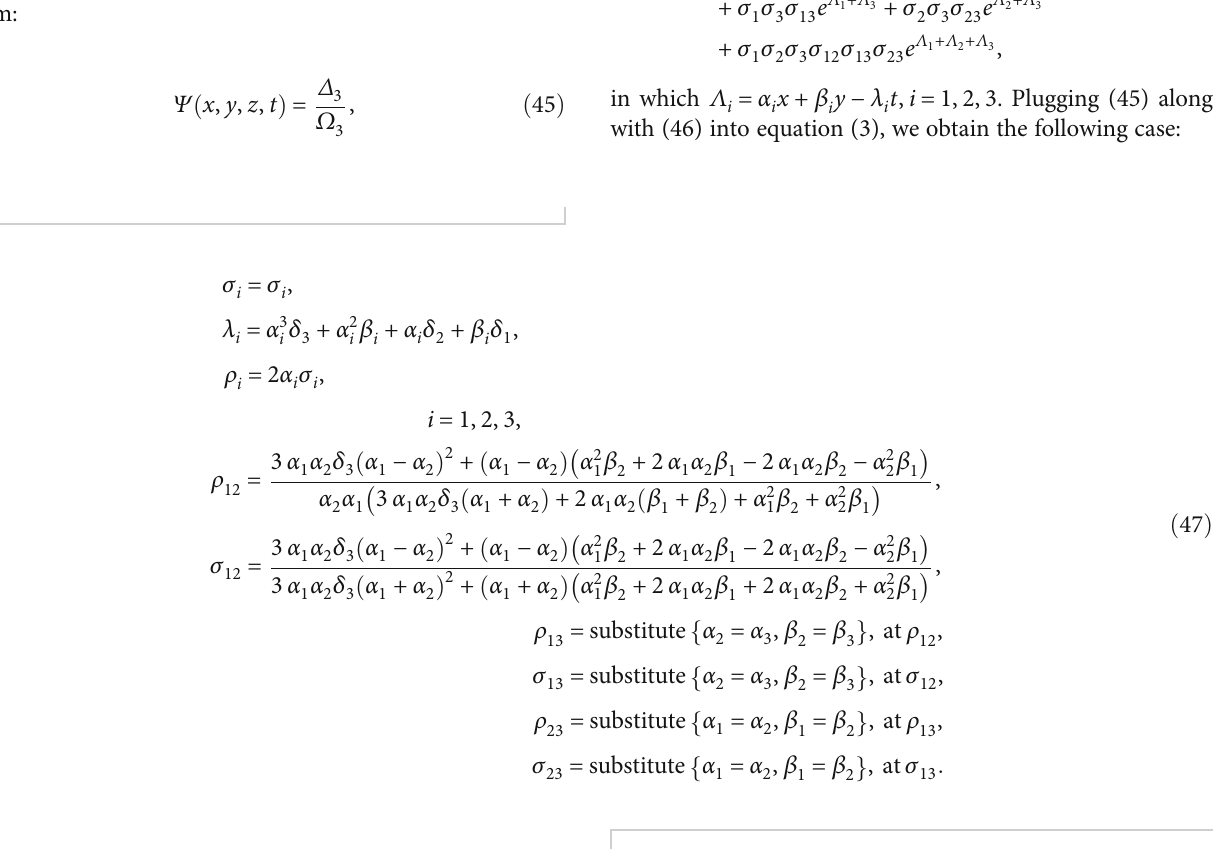
= 1 : 5, a ð t Þ = sin ð t Þ , 2